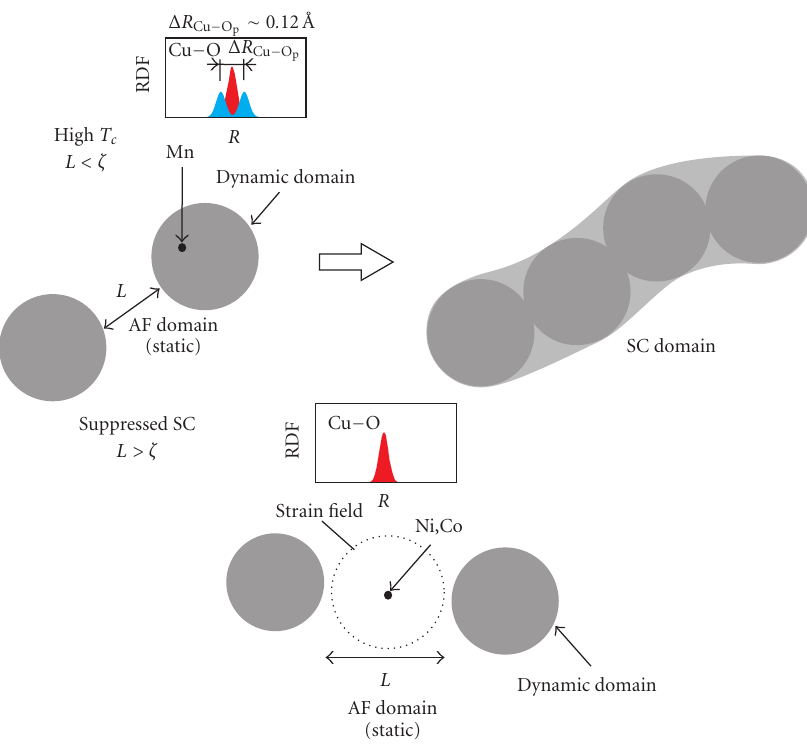
Figure 9: Schematic representation of quantum tunnelling in magnetic impurity doped La 1 − x Sr x CuO 4 ( x = 0 .